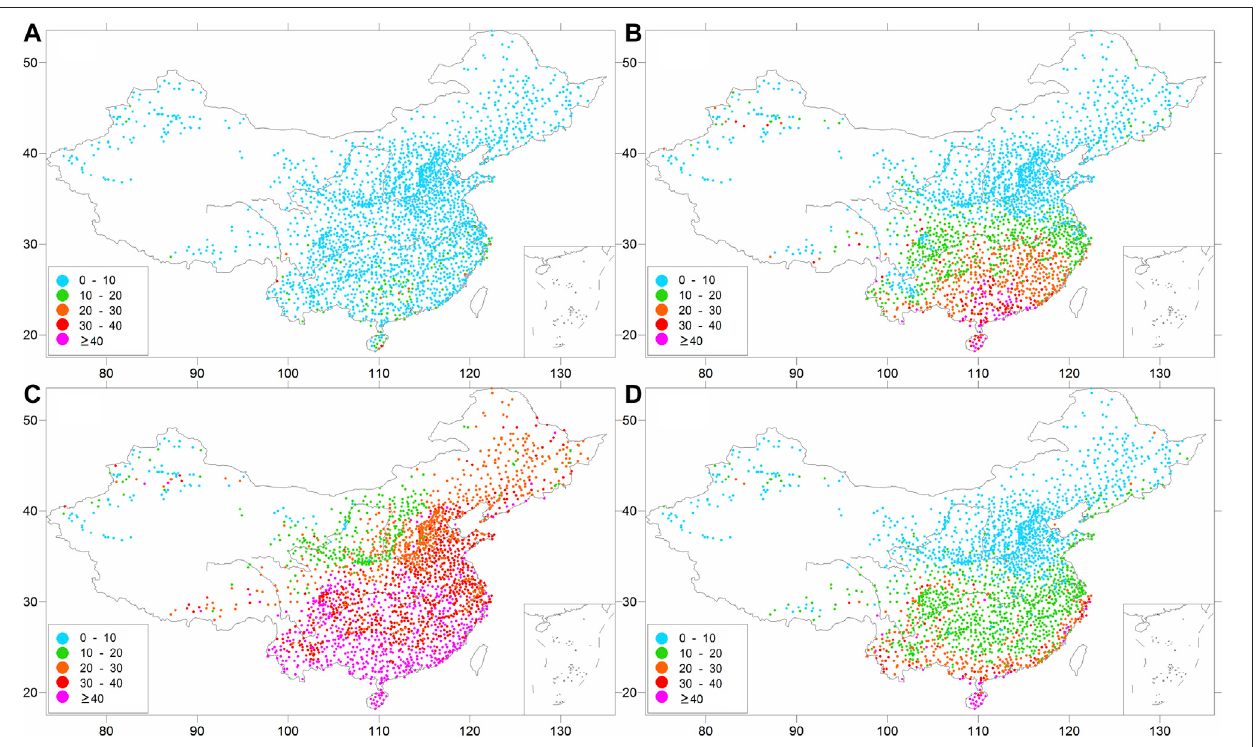
FIGURE 7 | Spatial distributions of the MAE for the precipitation (unit: mm/month) in (A) DJF, (B) MAM, (C) JJA, and (D) SON.